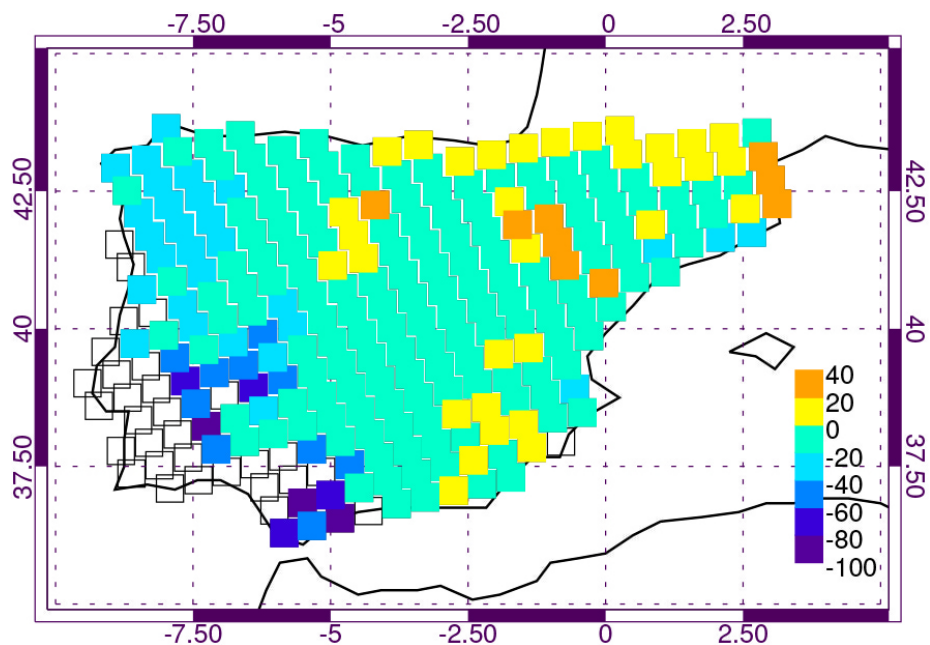
Figure 1. Percentage of change (coloured cells) in the frequency of ocurrence of cold waves with a three days rolling mean temperature ≤ 4.9 ◦ C for the period 2006–2010 compared to 1985–1989. Empty cells show grid boxes without enough events to compute a reliable frequency